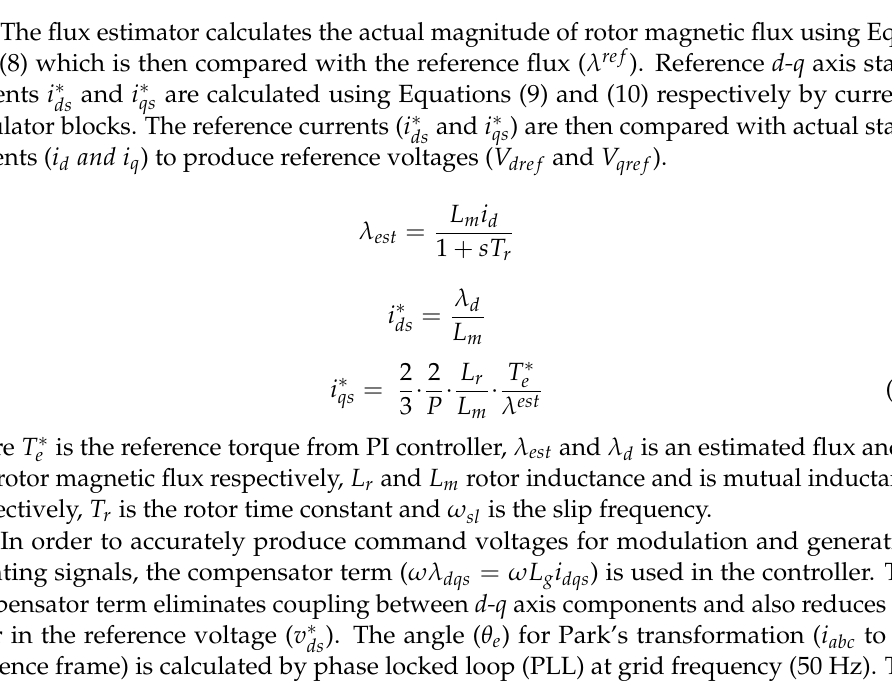
Figure 2. Control structure of MSC and GSC in